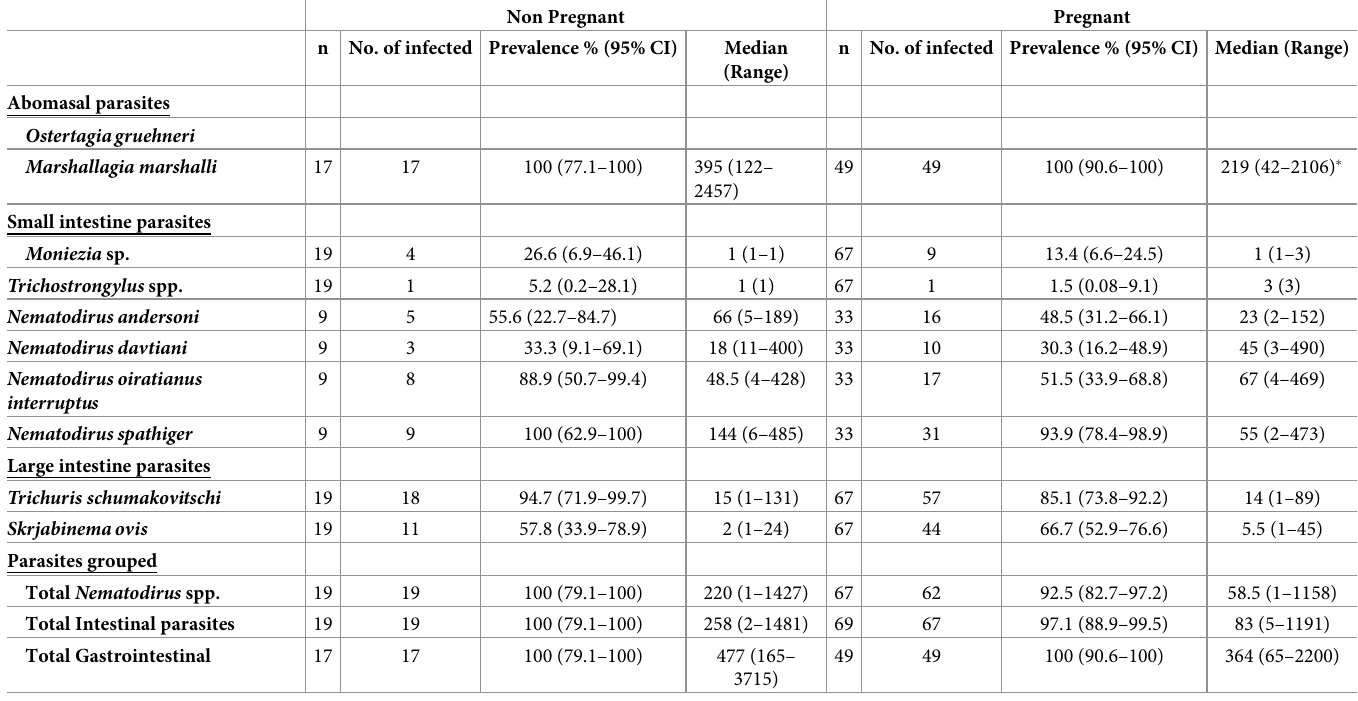
Table 5. Infection intensity and prevalence of gastrointestinal helminths in Dall´s sheep categorized by pregnancy